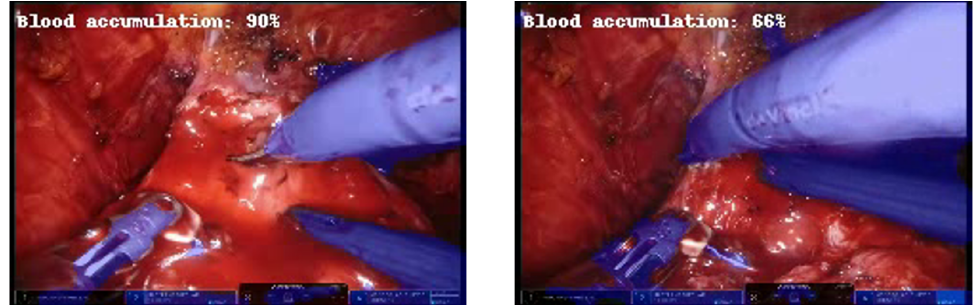
Figure 7. Example of frames at about 3 s distance in which the predicted percentage of blood accumulation decreases as the aspirator removes excess blood.